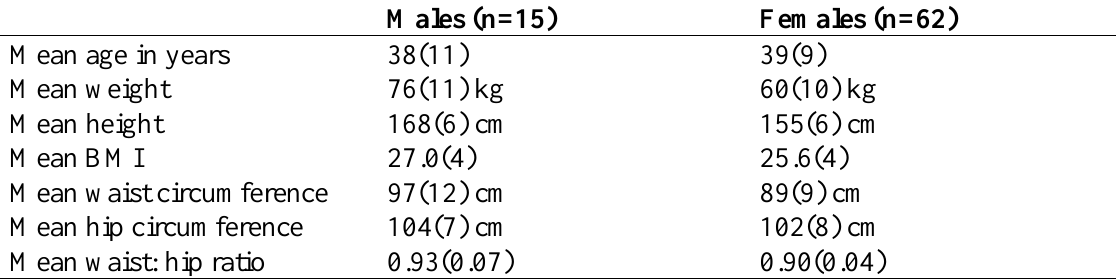
Mean waist: hip ratio